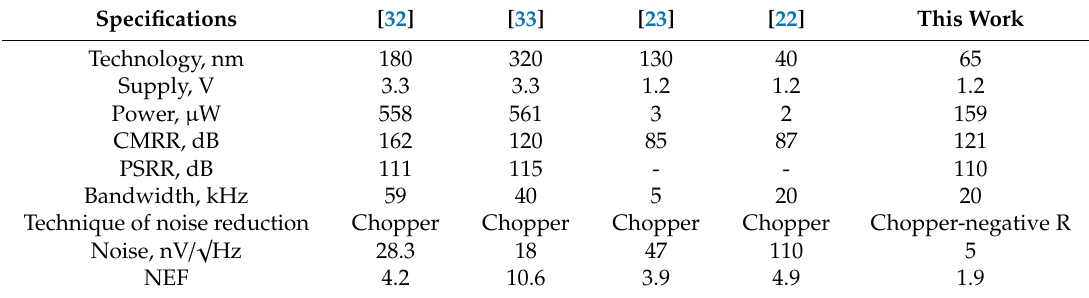
Table 1. Performances Comparison of the Proposed Preamplifier with the State-of-the